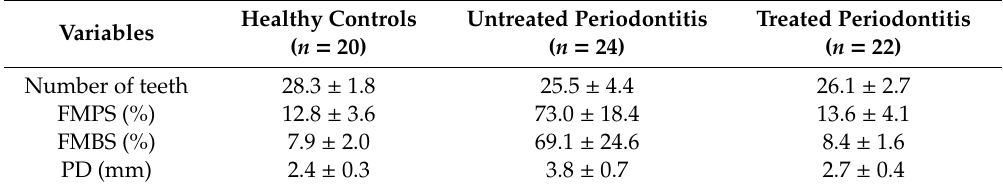
Table 1. Clinical characteristics of the experimental groups (mean ±